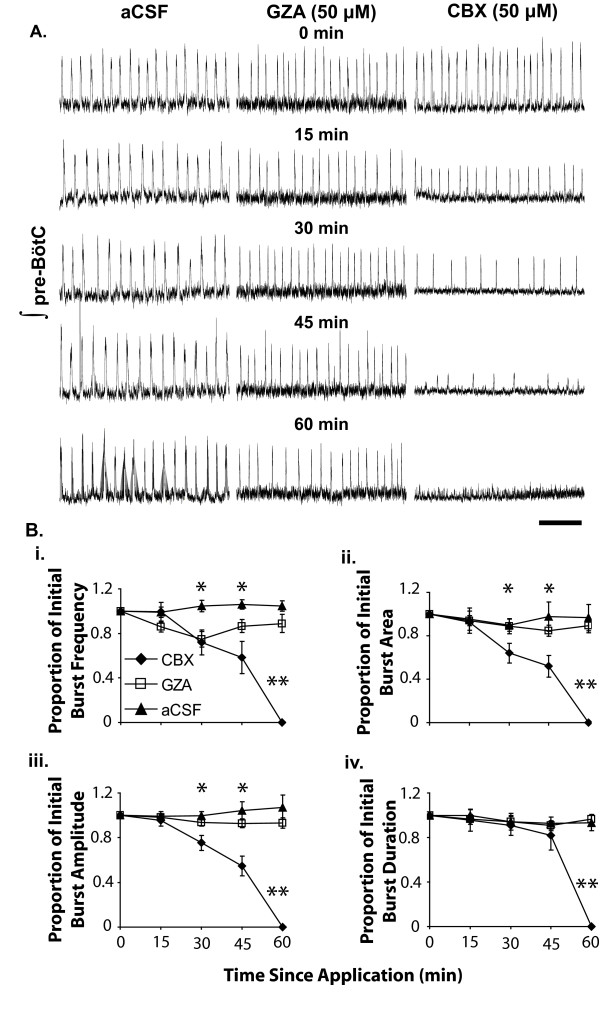
Effects of CBX and GZA on population-level bursting by the preBötC. A. Sample traces of extracellular activity recorded and integrated using a 50 ms time constant in the presence of GZA or CBX. Time bar represents 20 seconds. B. Whereas CBX decreased mean burst frequency within 20 min of application (i.), slices bathed in aCSF containing 50 μM GZA continued bursting at or near baseline frequency throughout recording (Two-way RM ANOVA with treatment by time as the source of variation d.f. = 4, F = 24.025, P < 0.001). B.ii. CBX decreased the area of integrated population bursts (Two-way RM ANOVA with treatment by time as the source of variation d.f. = 4, F = 25.783, P < 0.001). B.iii., Decreased burst area with CBX treatment appears to have been due to CBX decreasing burst amplitude beginning at 30 min of treatment (Two-way RM ANOVA with treatment by time as the source of variation d.f. = 4, F = 59.14, P < 0.001), as burst duration was seemingly unaffected by CBX up to the point at which bursting ceased (B.iv). *CBX value different from aCSF control at P < 0.05. **In these figures, the 60 min data point is presented to underscore that CBX terminated preBötC bursting within 1 h of treatment.